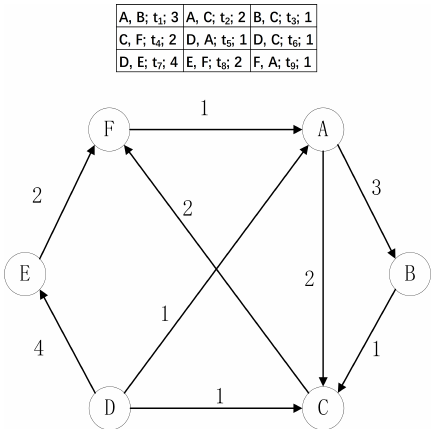
Figure 1. A sample graph